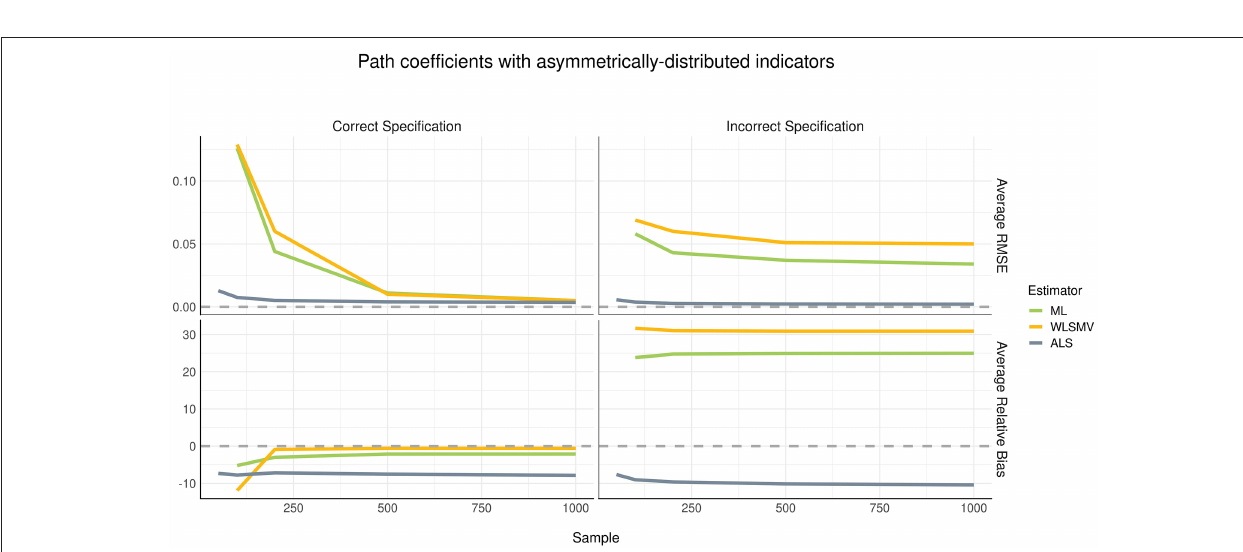
FIGURE 4 | Estimation error and bias in structural path coefficients with symmetrically-distributed indicators.